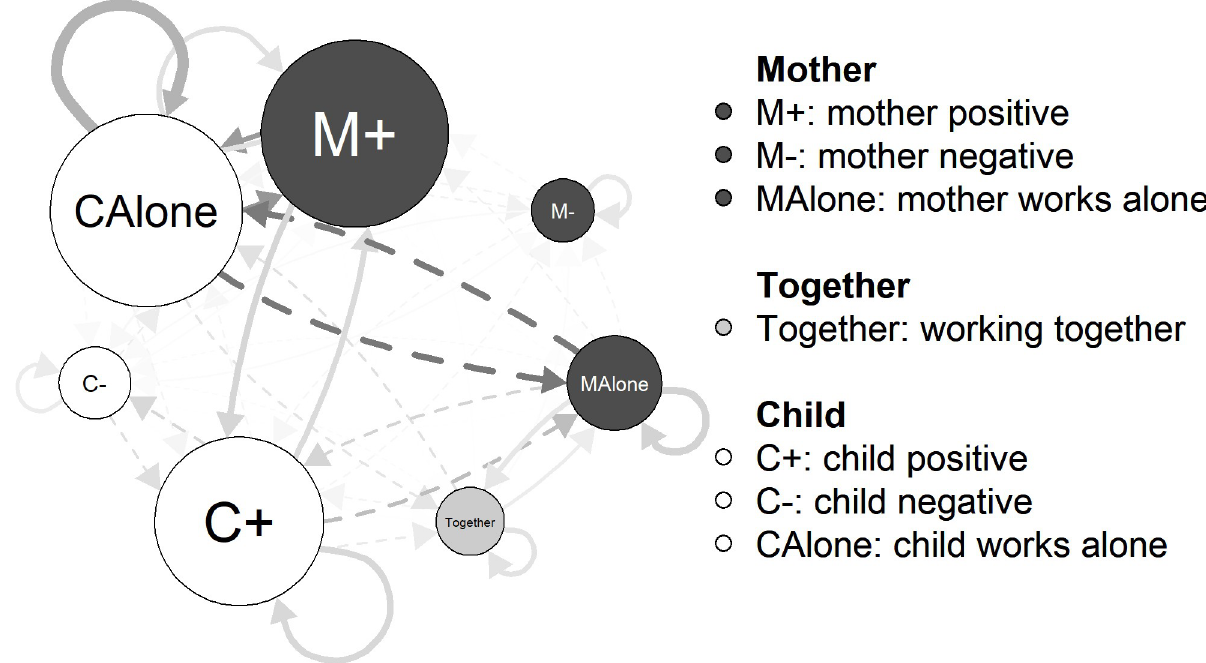
Fig 2. Average network of the main sample. Categories are depicted as nodes, sequencing likelihood as arrows between them. Node size is adapted to the average relative frequency of the category. Please note that a minimum node size was introduced, to warrant the readability of the node labels. Thickness and saturation of the links depict degree of deviance from random behavior. Dashed lines indicate behavior that is shown less than expected. Auto-loops are downscaled to depict the sequencing likelihoods between different behavior categories more